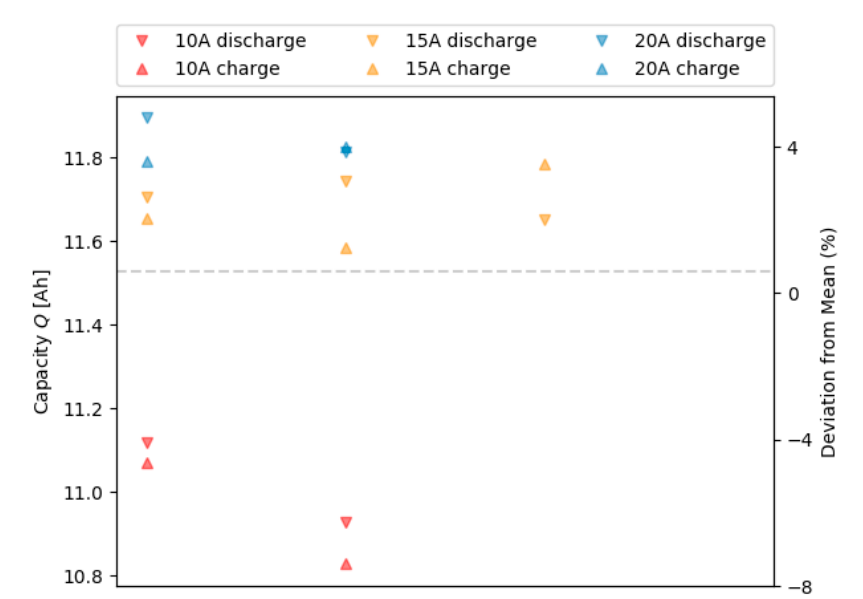
Figure 6. Typical charge and discharge cycle at constant current ( I Batt = ∓ 10 A), followed by constant voltage.